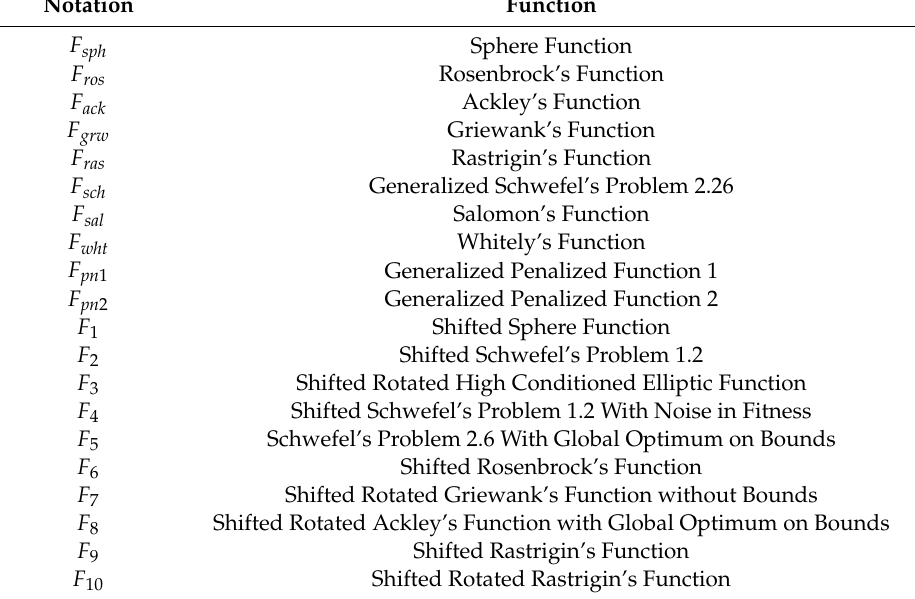
Table 1. Benchmark